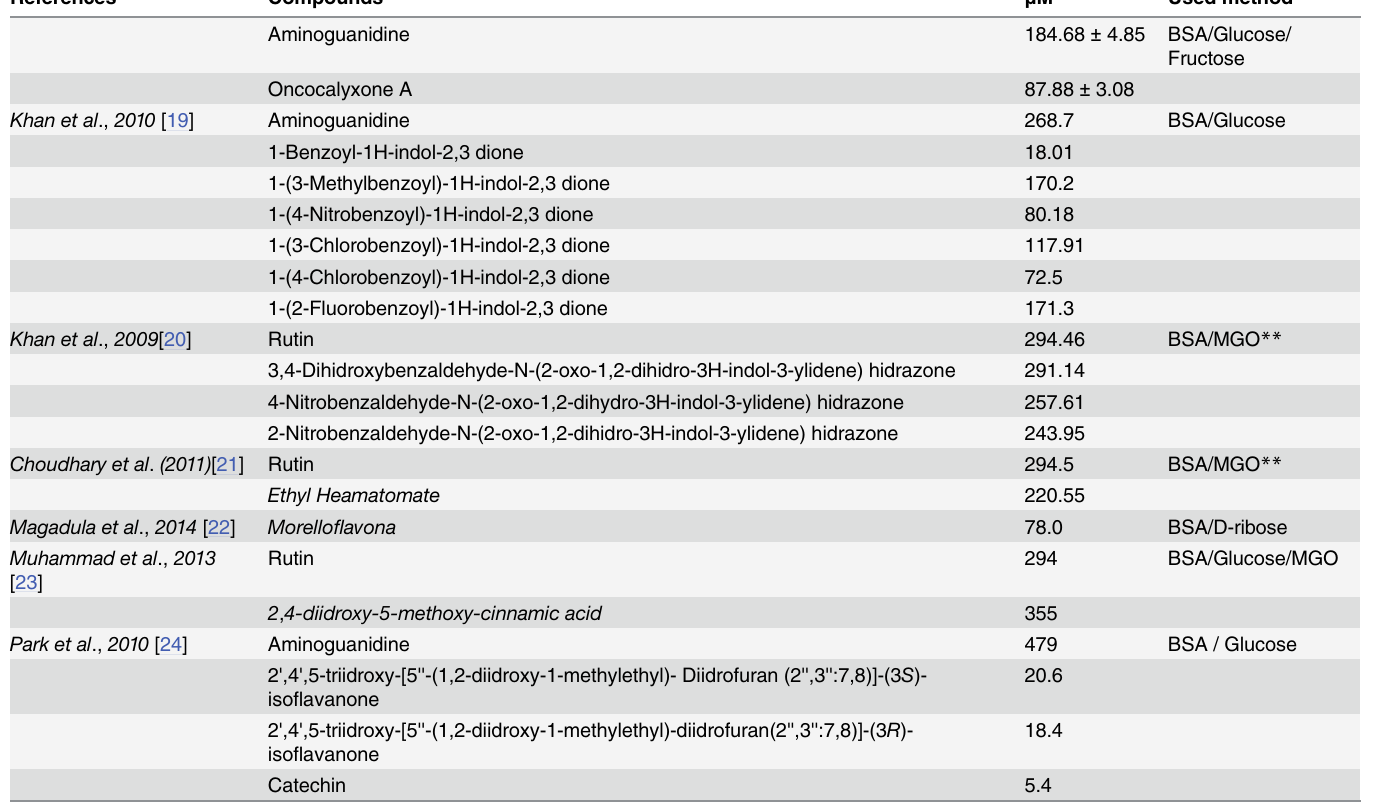
Table 1. Anti-glycation activity of pure